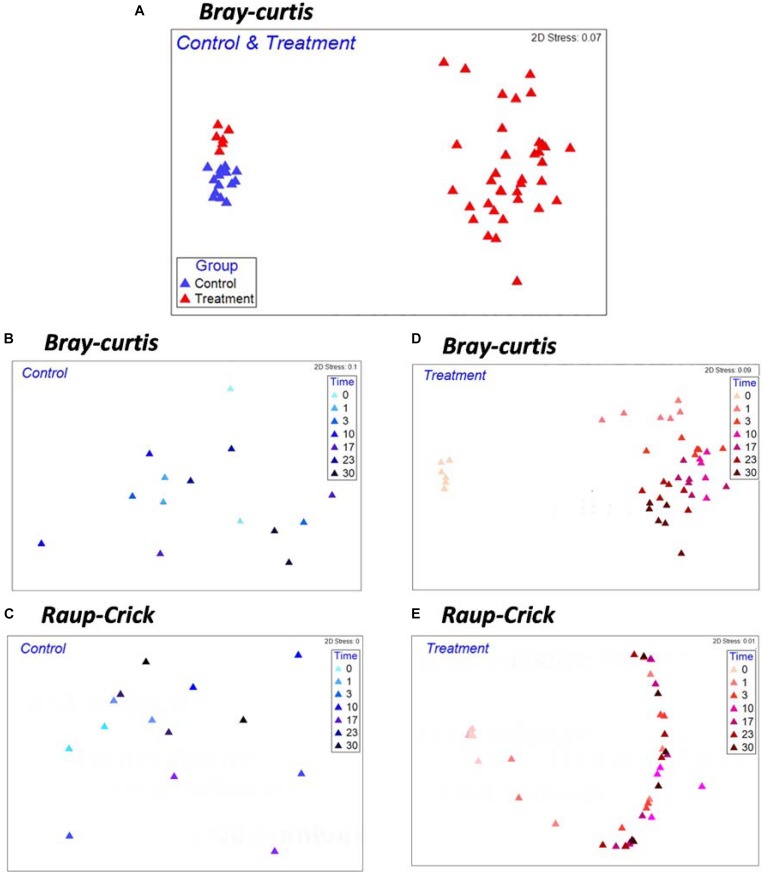
Non-metric multi-dimensional scaling (NMDS) ordinations based on Bray–Curtis Index (A,B,D) and βRC
(C,E) for Control and Treatment examining the effects of Microcystis biomass addition on patterns of microbial community compositions. Each symbol in the NMDS plot represents a sample collected during the incubation.